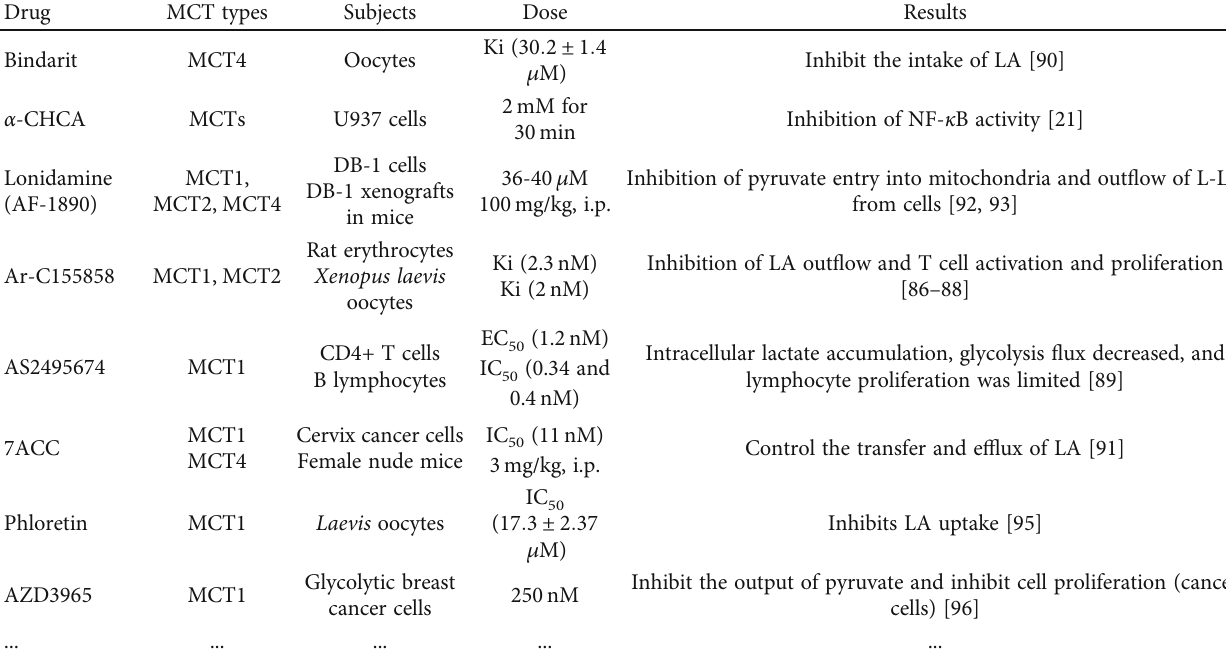
Table 1: Drugs that act on monocarboxylate